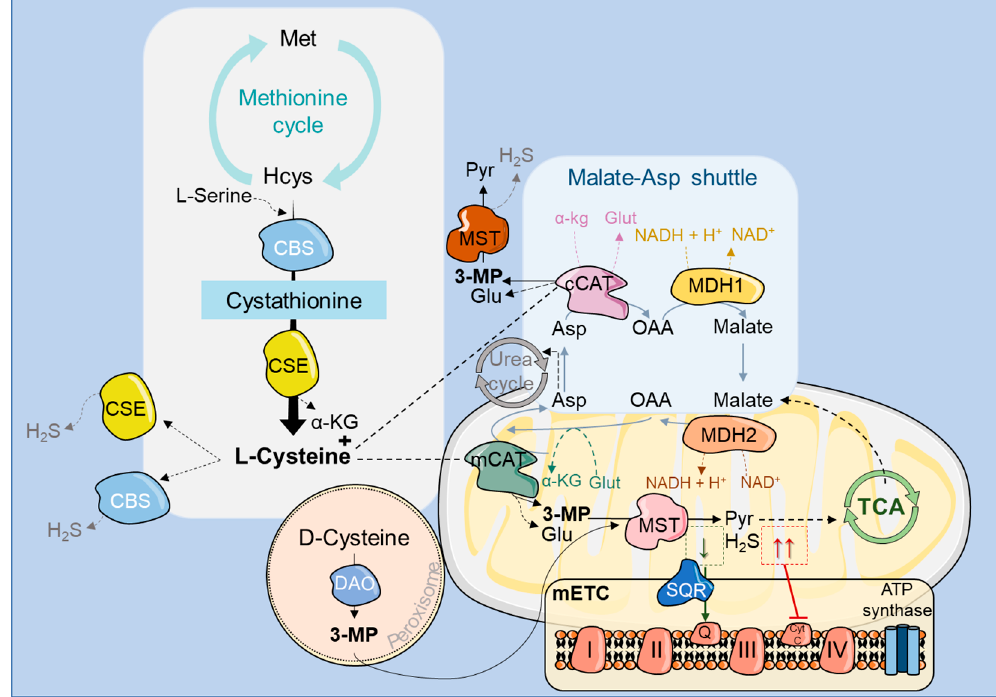
Figure 2. Metabolic pathways that rely on CAT activity. The methionine cycle produces homocysteine, which can be metabolized by cystathionine- β -synthase (CBS) and cystathionine- γ -lyase (CSE), two H 2 S synthesizing enzymes, leading to the production of L -cysteine. mCAT can then catalyze the transamination of L -cysteine, producing 3-mercaptopyruvate (3-MP) (and glutamate, Glu), which is then a substrate for MST, yielding H 2 S and pyruvate (Pyr), the latter entering the TCA cycle. D -cysteine can also be used in this reaction; however, it must be previously converted to 3-MP by the peroxisomal enzyme D -amino acid oxidase (DAO). At low concentrations, H 2 S stimulates the mitochondrial electron transport chain (mETC) by donating electrons that are transferred by sulfide:quinone oxidoreductase (SQR) to coenzyme Q (Q). At higher concentrations H 2 S binds to and inhibits cytochrome C oxidase (Cyt C), blocking electron transfer and energy production. CAT can also act on L -tyrosine, L -phenylalanine, L -tryptophan, and aspartate (Asp) metabolism, providing substrates that can enter other pathways, such as the TCA and the urea cycle. CAT is an essential element of the malate-aspartate shuttle that catalyzes the bidirectional conversion of aspartate (Asp) and α -ketoglutarate into oxaloacetate (OAA) and glutamate, with support from MDH1/2 enzymes.